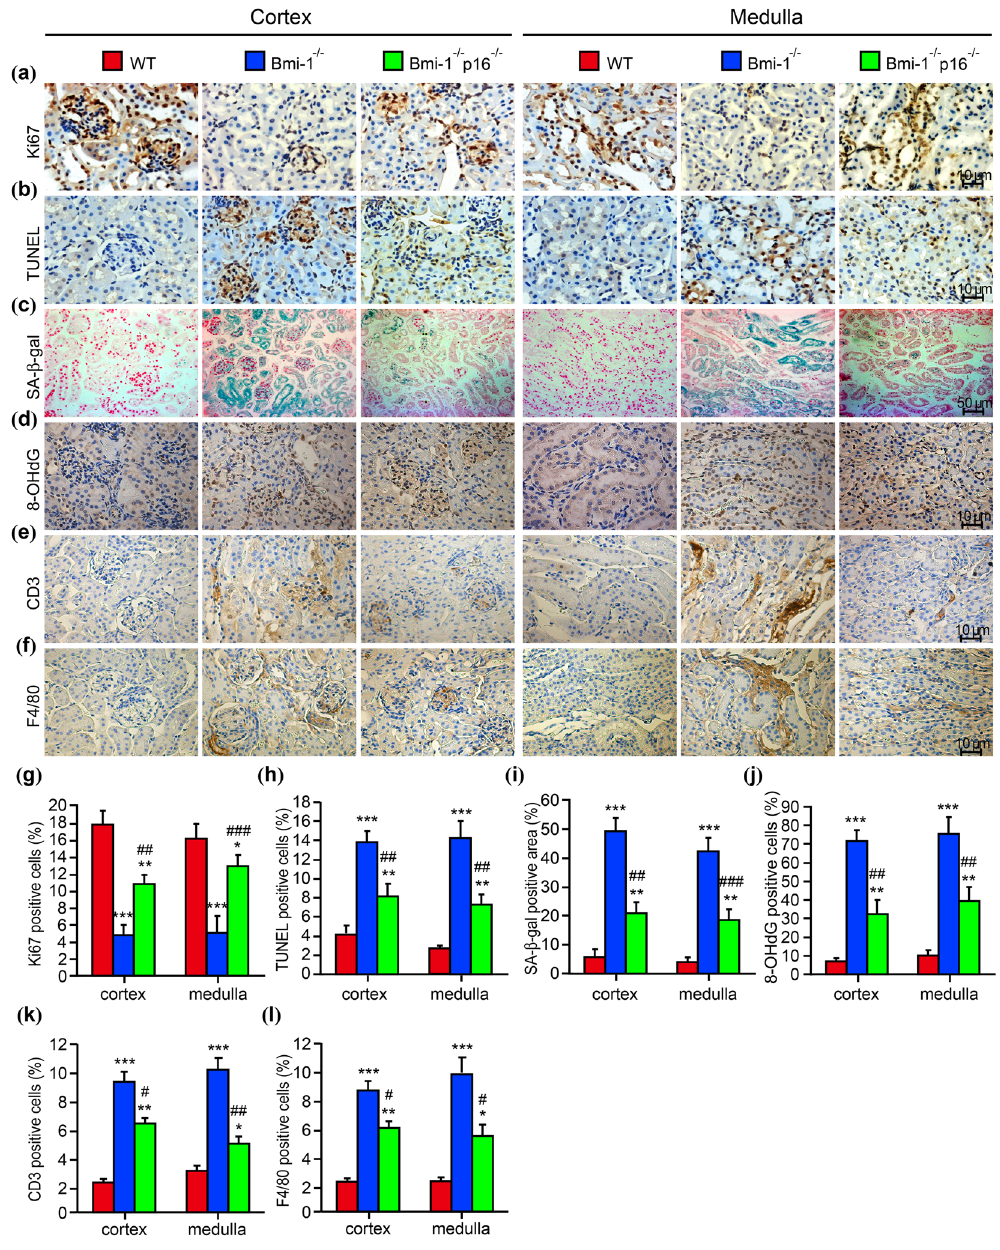
Figure 2. P16 deletion improved renal aging and associated inflammatory cell infiltration in Bmi - 1 − / − mice. Representative micrographs of paraffin-embedded kidney sections stained immunohistochemically for ( a ) Ki67 and ( b ) TUNEL; histochemically for ( c ) senescence associated- β -galactosidase (SA- β -gal); and immunohistochemically for ( d ) 8-hydroxyguanosine (8-OHdG), ( e ) CD3 and ( f ) F4/80. Percentage of ( g ) Ki67-positive cells, ( h ) TUNEL-positive cells, ( i ) SA- β -gal-positive area, or cells positive for ( j ) 8-OHdG, ( k ) CD3, or ( l ) F4/80 relative to total cells or area. Six mice per group were used for these experiments. Values are mean ± SEM from 6 determinations per group. * P < 0.05, ** P < 0.01, *** P < 0.001 compared with WT group; # P < 0.05, ## P < 0.01, ### P < 0.001 compared with Bmi - 1 − / −